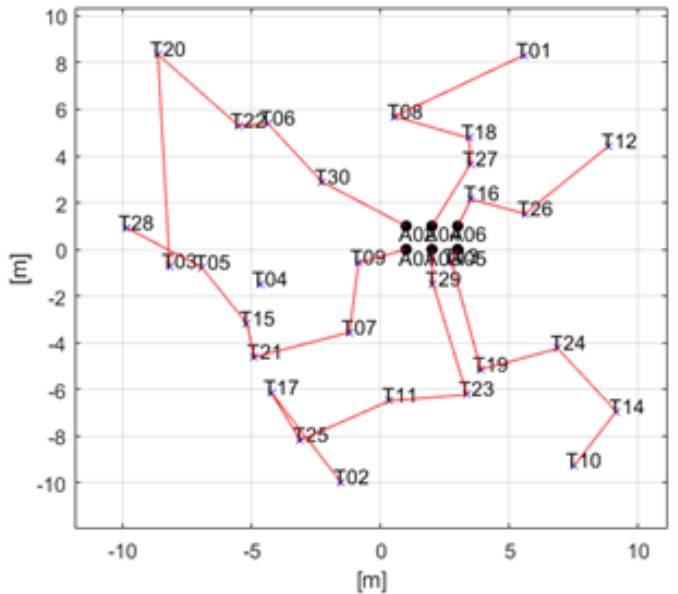
Figure 13. 2-D result of TACTAR for a huge case applying a modified time-discounted reward scheme.